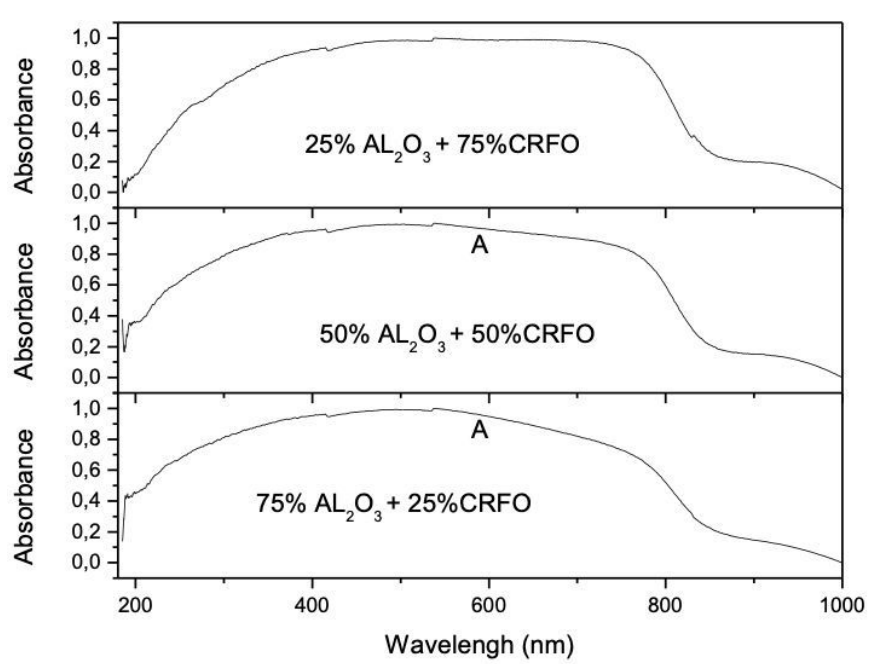
Figure 8. UV-VIS